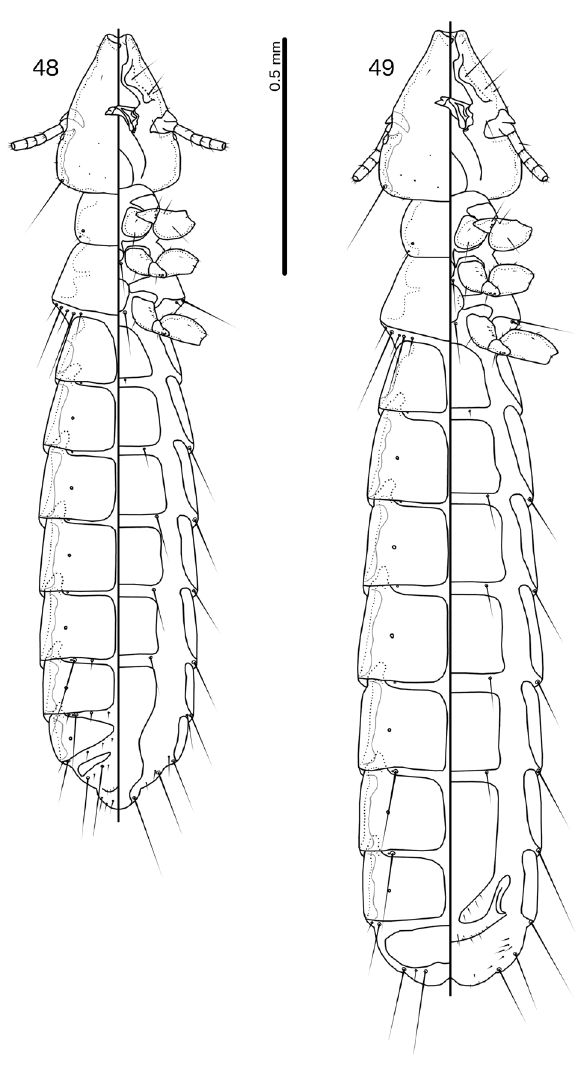
Figures 48, 49. Brueelia kratochvili Balát, 1958, ex Motacilla flava Linnaeus, 1758 48 Male habitus, dorsal and ventral views 49 Female habitus, dorsal and ventral views.